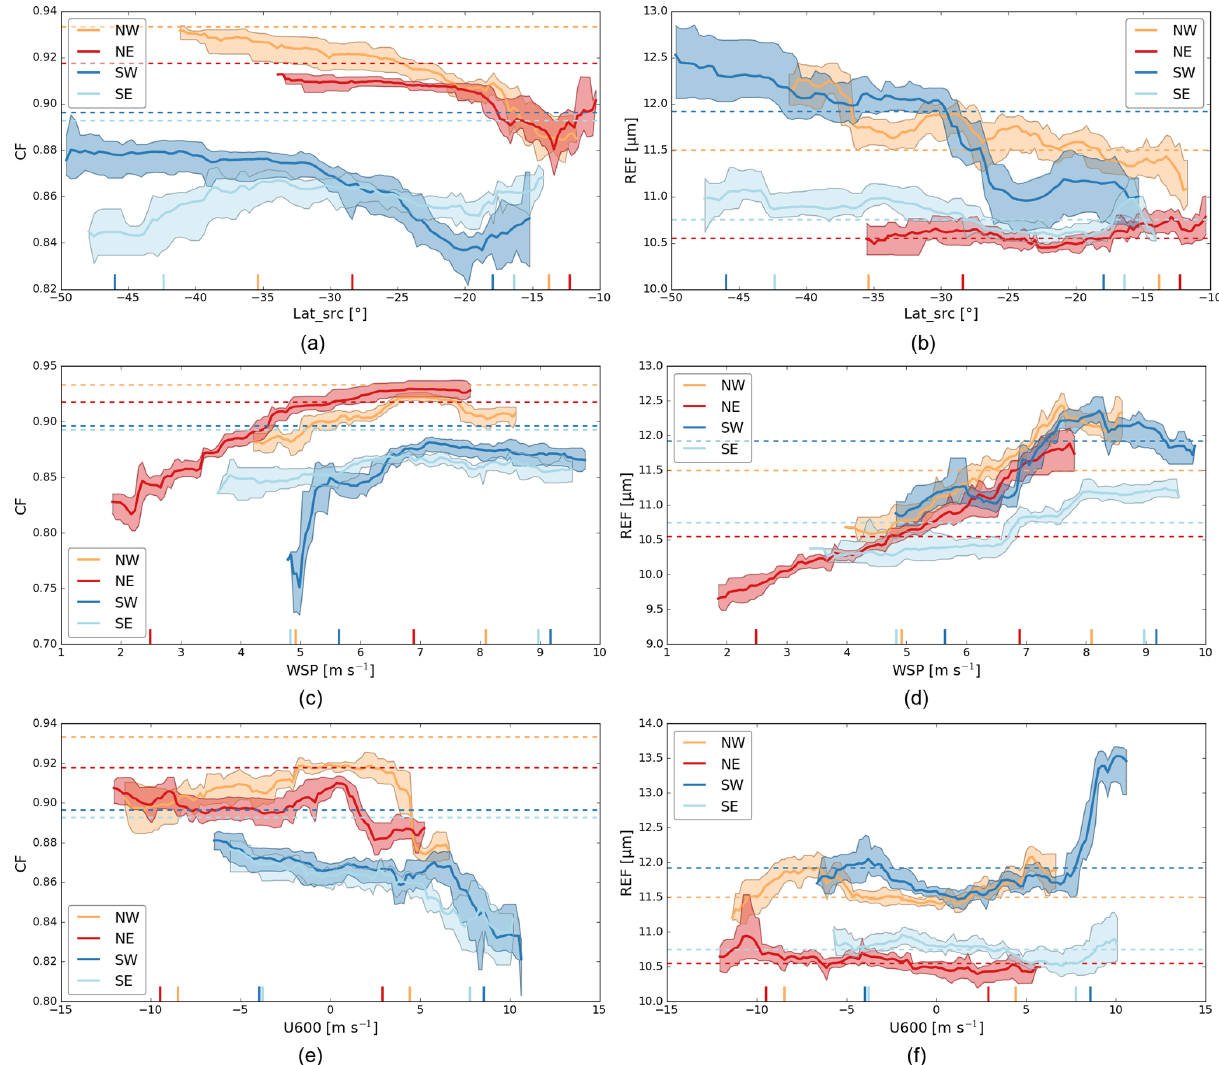
Figure 4. Mean partial dependence of CF and REF on source latitude of air mass (a, b) , surface wind speed (c, d) and zonal winds at 600hPa (e, f) in the four subregions (colors) during JAS. Details as in Fig.